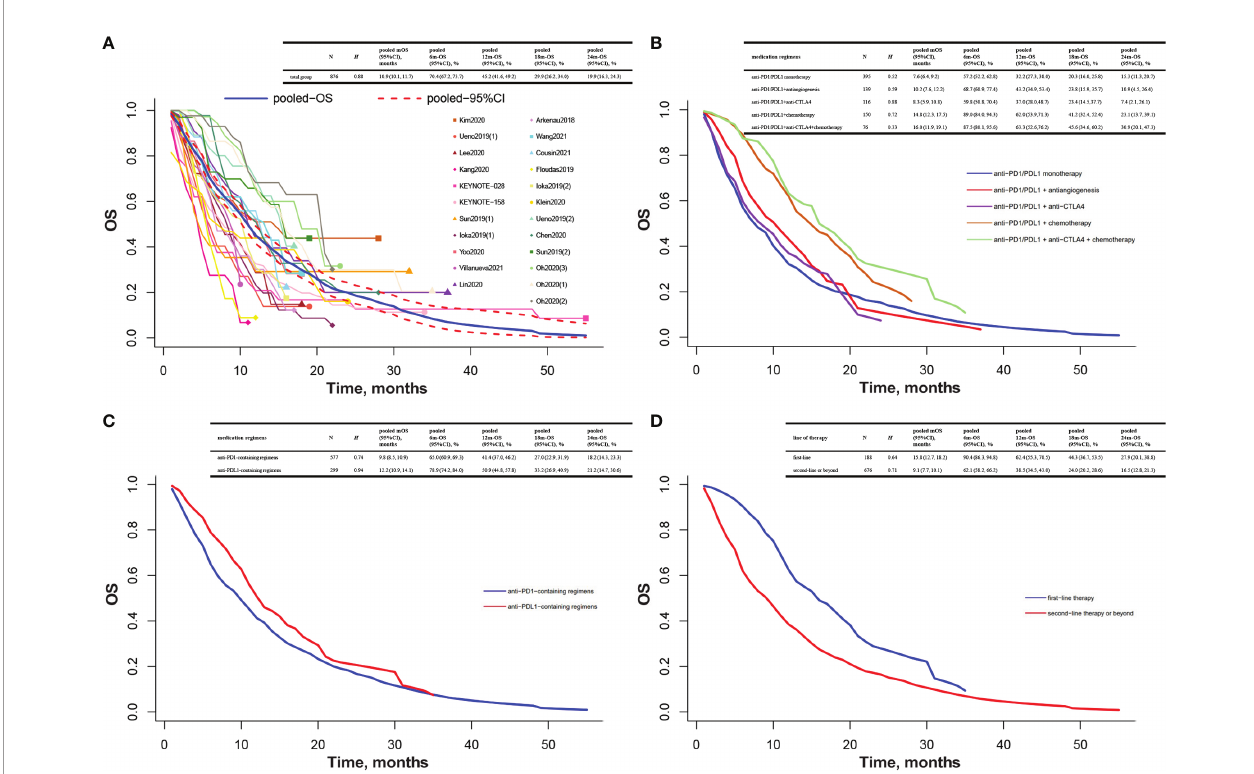
FIGURE 3 | Pooled Kaplan – Meier estimate of OS. (A) Total group; (B) anti-PD1/PDL1 monotherapy, anti-PD1/PDL1 combined with antiangiogenesis or anti-CTLA4 or chemotherapy, or combination of anti-PD1/PDL1, anti-CTLA4, and chemotherapy; (C) anti-PD1-containing regimens and anti-PDL1-containing regimens; (D) fi rst- line therapy and second-line therapy or beyond. Heterogeneity was assessed by H statistic, with H < 1.2 considered as being indicative of insigni fi cant heterogeneity. Four studies had more than one subgroup of interest. Speci fi cally, patients were allocated to the nivolumab group [Ueno2019(1)] or the nivolumab/GemCis group [Ueno2019(2)] in the Ueno2019 study; the PD1 inhibitor monotherapy group [Sun2019(1)] or the PD1 inhibitor plus chemotherapy group [Sun2019(2)] in the Sun2019 study; the durvalumab group [Ioka2019(1)] or the durvalumab/tremelimumab group [Ioka2019(2)] in the Ioka2019 study; the biomarker group [receiving durvalumab/tremelimumab with GemCis, Oh2020(1)], the durvalumab/tremelimumab with GemCis group [Oh2020(2)], or the durvalumab with GemCis group [Oh2020(3)] in the Oh2020 study. OS, overall survival; mOS, medium overall survival; CI, con fi dence interval; 6m-OS, 6-month overall survival; 12m-OS, 12-month overall survival; 18m-OS, 18-month overall survival; 24m-OS, 24-month overall survival; PD1, programmed cell death protein 1; PDL1, programmed cell death ligand 1; CTLA4, cytotoxic T lymphocyte antigen 4; GemCis, gemcitabine +